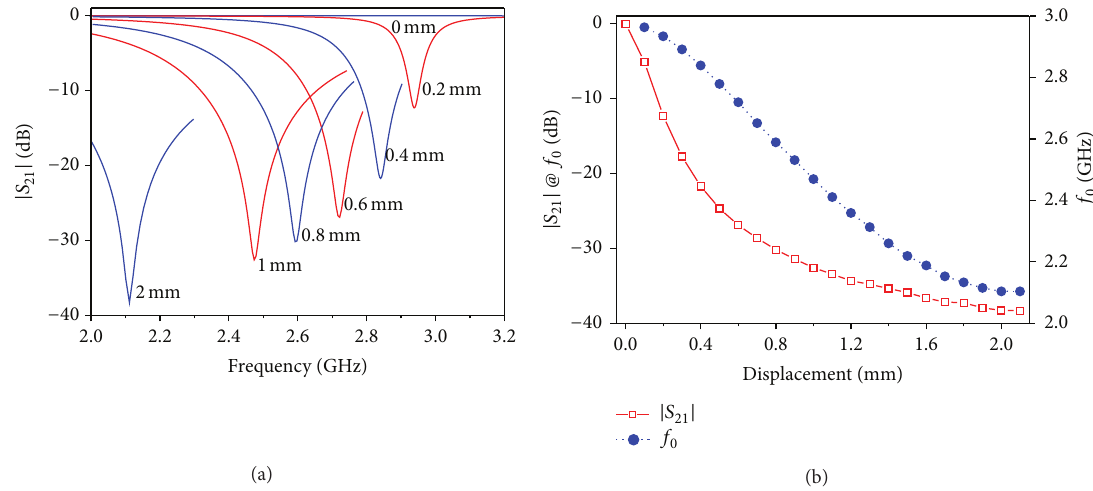
Figure 6: Transmission coefficient (a) and dependence of the notch magnitude and frequency (b) with lateral displacement corresponding to the structure of Figure 4, inferred from the lossy electromagnetic simulation. The displacement for maximum notch magnitude, that is, the dynamic range, is 2